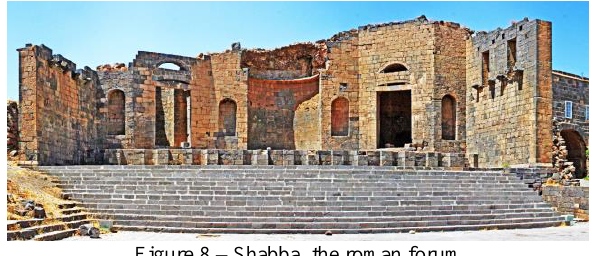
Figure 8 – Shabba, the roman forum